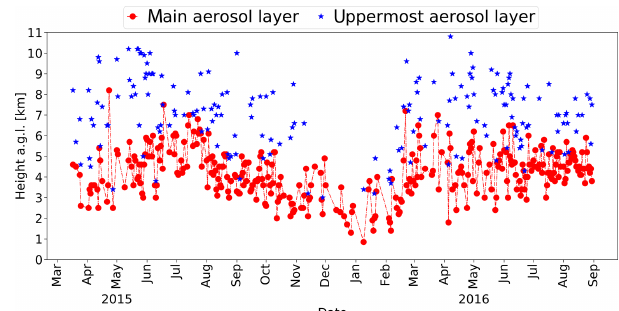
Figure 3. Top heights of the main aerosol layer (red) and of the uppermost aerosol layer (blue). All lidar backscatter profiles were inspected manually, i.e., an automated retrieval of layer top heights was not applied.